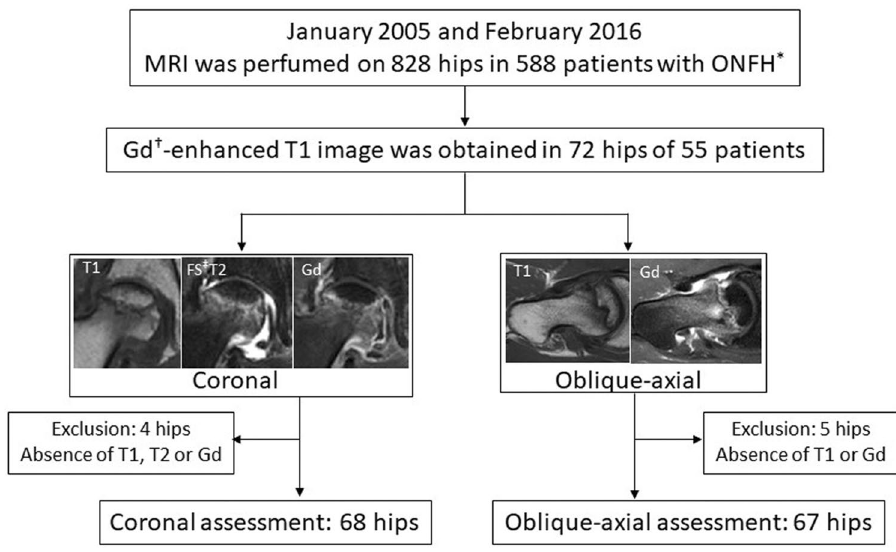
Figure 2. Flowchart demonstrating selection of images of coronal and oblique-axial planes of MRI. *Osteonecrosis of the femoral head, † Gadolinium, ‡